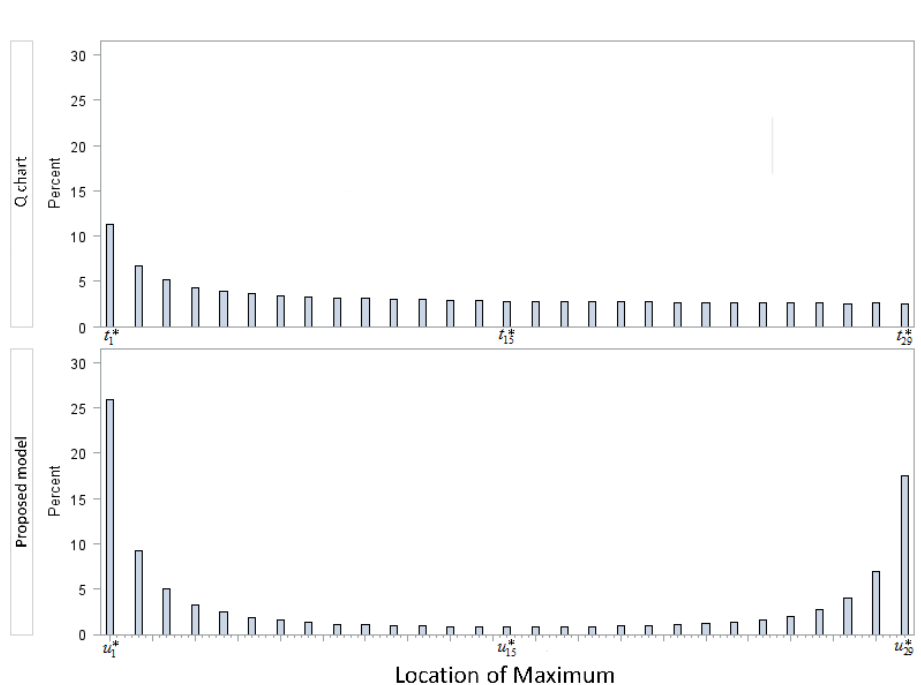
Figure 6. Location of maximum order statistics: m = 29 and n =